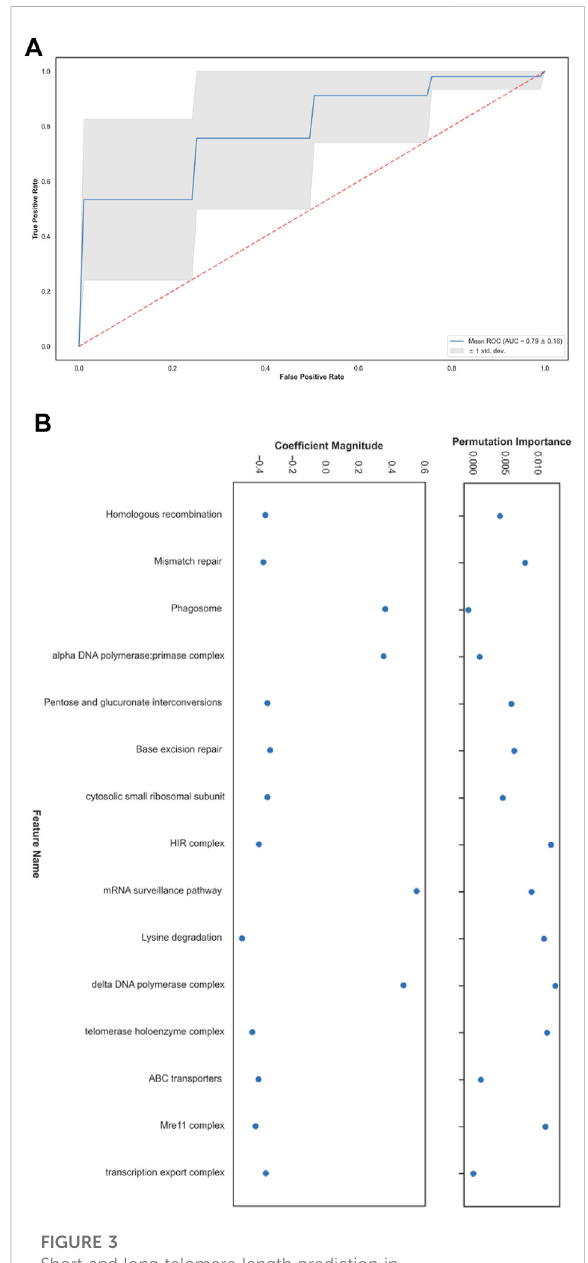
FIGURE 3 Short and long telomere length prediction in Schizosaccharomyces pombe . (A) Receiver operating characteristic (ROC) plot. (B) The top fi fteen features with the greatest contribution to the classi fi cation according to coef fi cients learned by the linear model and their permutation